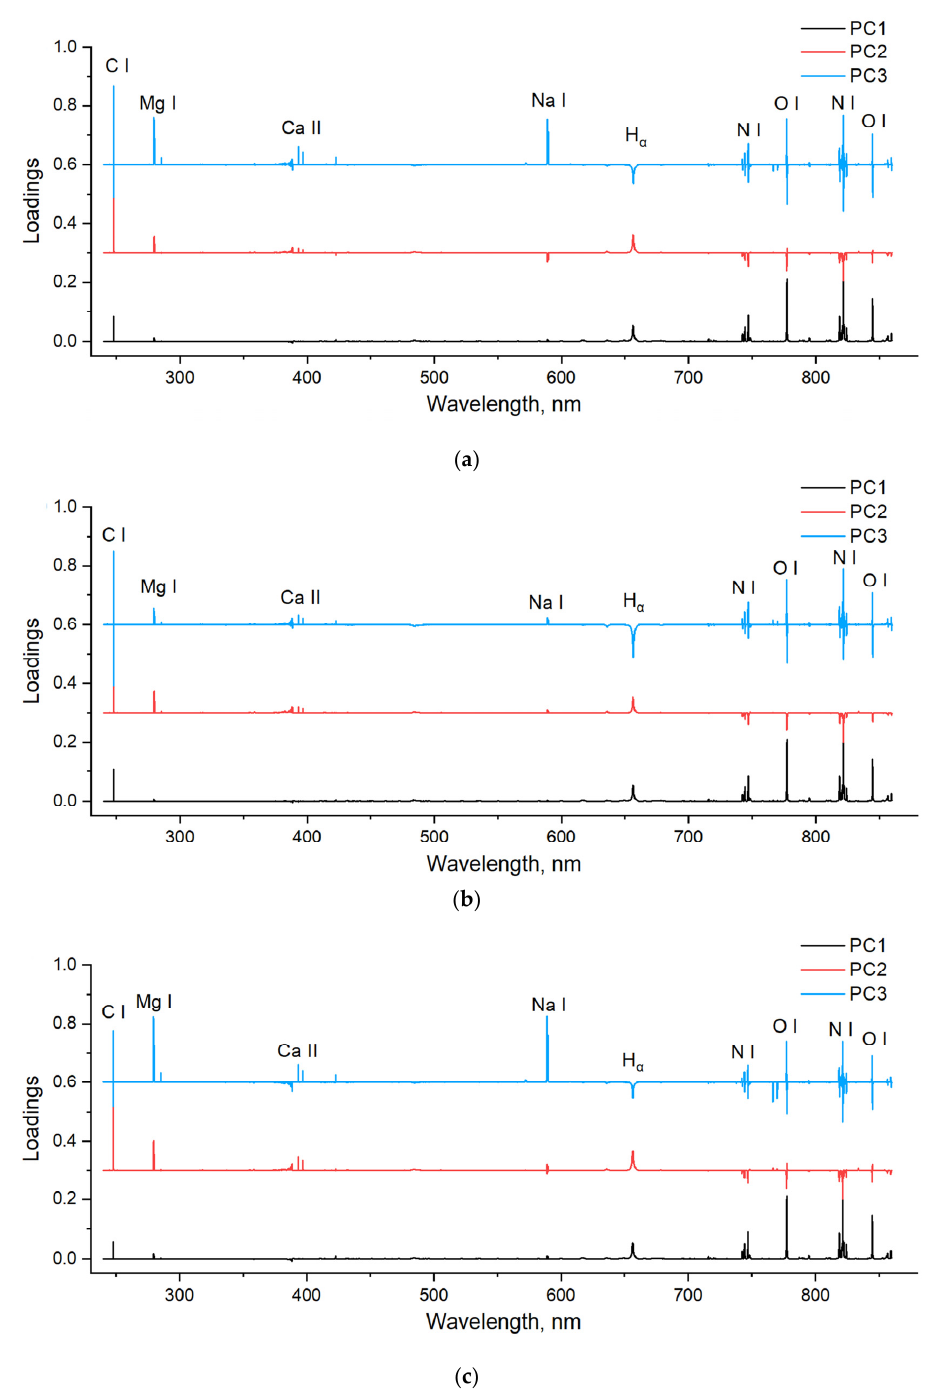
Figure 3. Loadings of the first three principal components for ( a ) all honey (including acacia honey and multi-floral honey), ( b ) acacia honey, and ( c ) multi-floral honey.